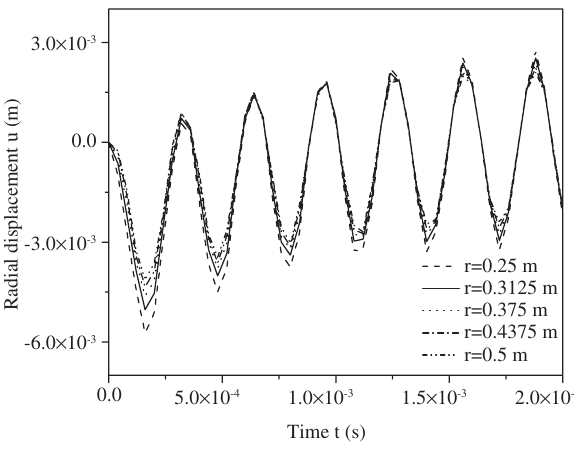
Figure 7 Response histories of radial stress in the FGM hollow cylinder at different thicknesses, where n =